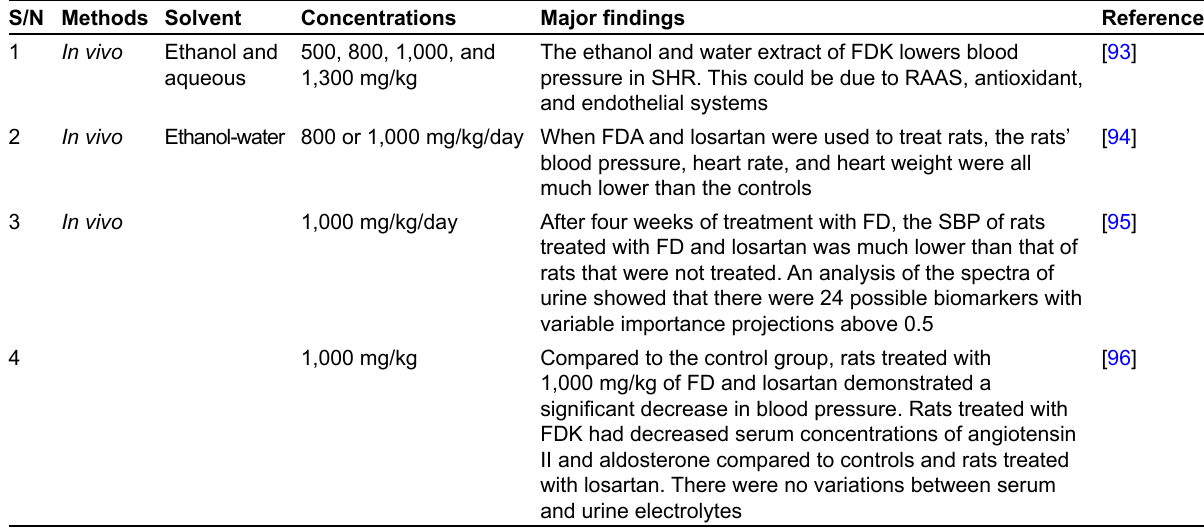
Table 5. Antihypertensive activity of